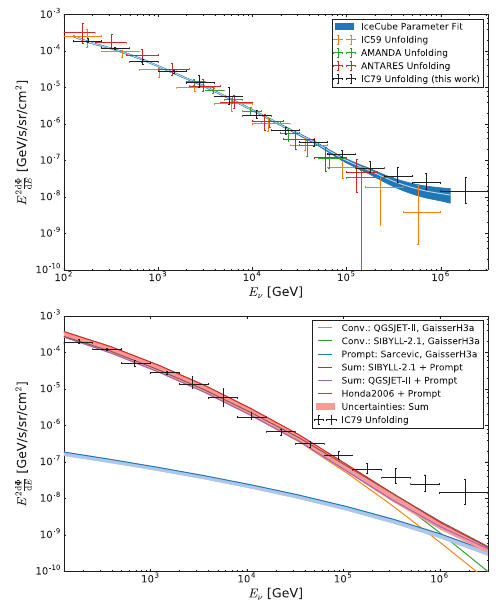
Figure 1. The atmospheric muon neutrino flux measured by sev- eral experiments from 100 GeV to several PeV (upper), and the comparison of IceCube measurements and the theoretical pre- dictions of conventional and prompt fluxes (lower). Figures are taken from [1].